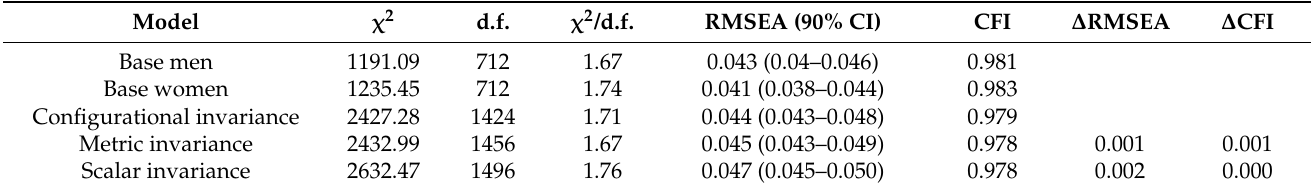
Table 5. Model fit indices for measurement invariance by